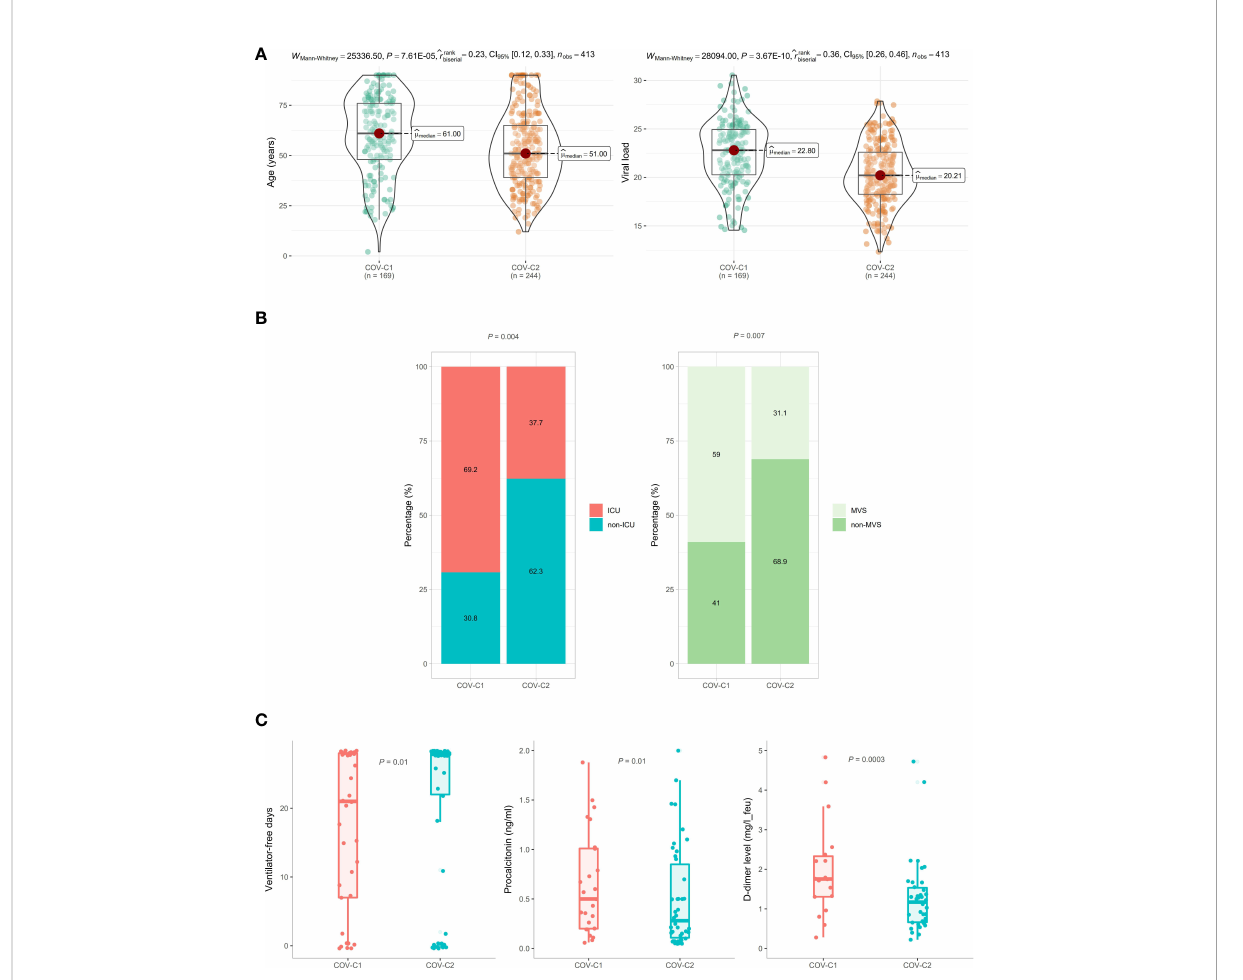
FIGURE 3 Comparisons of clinical features between COV-C1 and COV-C2 patients. (A) In GSE152075, COV-C2 patients are younger and have signi fi cantly lower viral loads than COV-C1 patients. (B) COV-C2 has signi fi cantly lower proportions of ICU patients and MVS patients than COV-C1. Fisher ’ s exact test P -values are shown. (C) COV-C2 patients are with signi fi cantly more ventilator-free days and have signi fi cantly lower levels of D- dimer and procalcitonin than COV-C1 patients. One-tailed Mann – Whitney U test P -values are shown. The results shown in (B, C) were obtained by analyzing the dataset